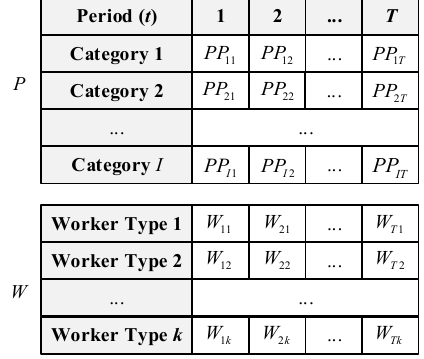
Figure 1. An example of a chromosome.